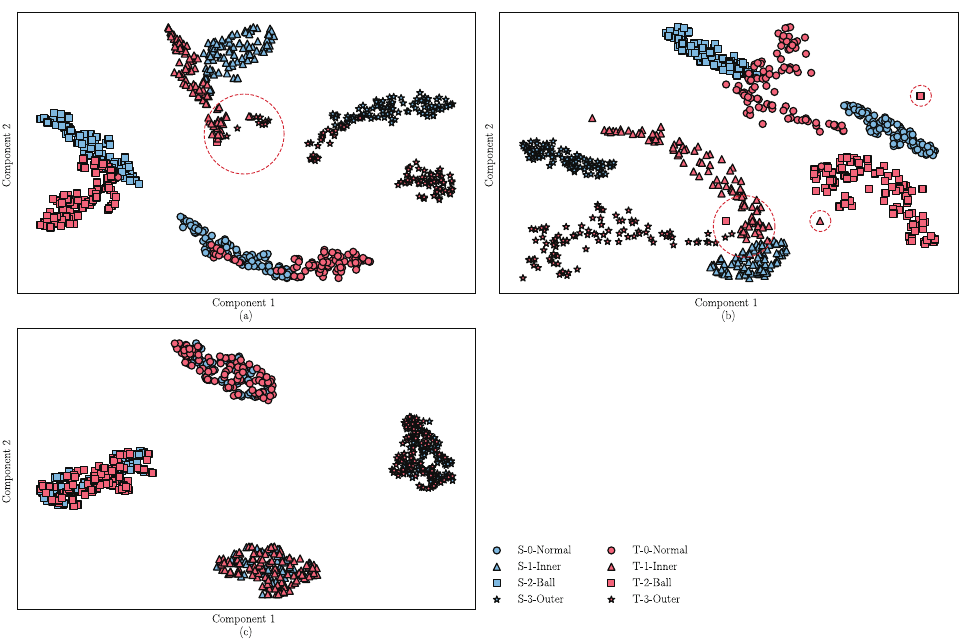
Figure 8. Feature visualization of the different methods for the DDS dataset: ( a ) DANN, ( b ) ADDA, and ( c ) JADA.